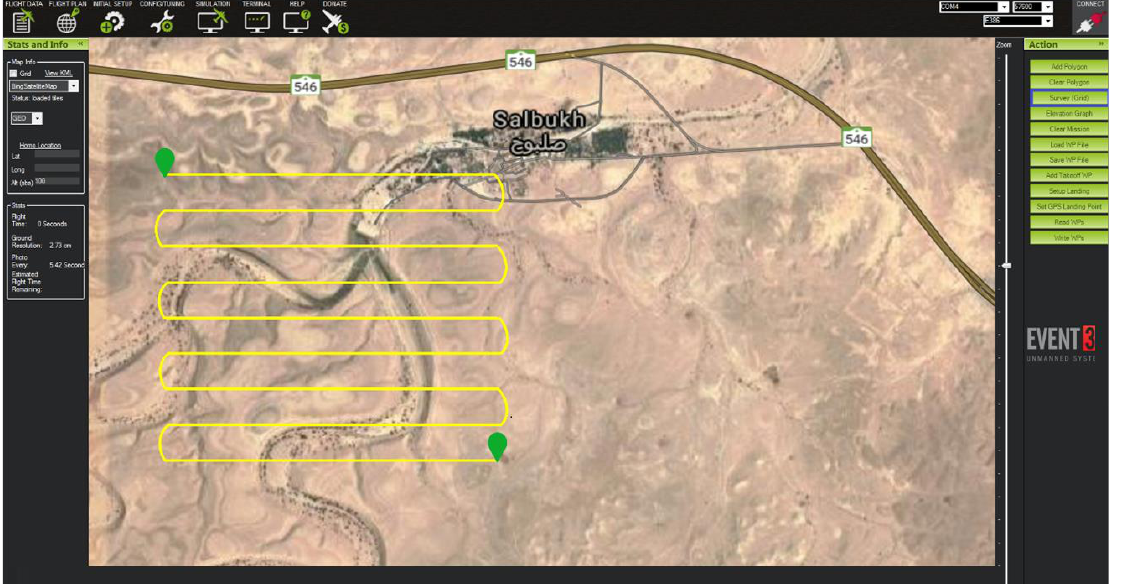
Figure 3. Strips searching technique performed by a drone.